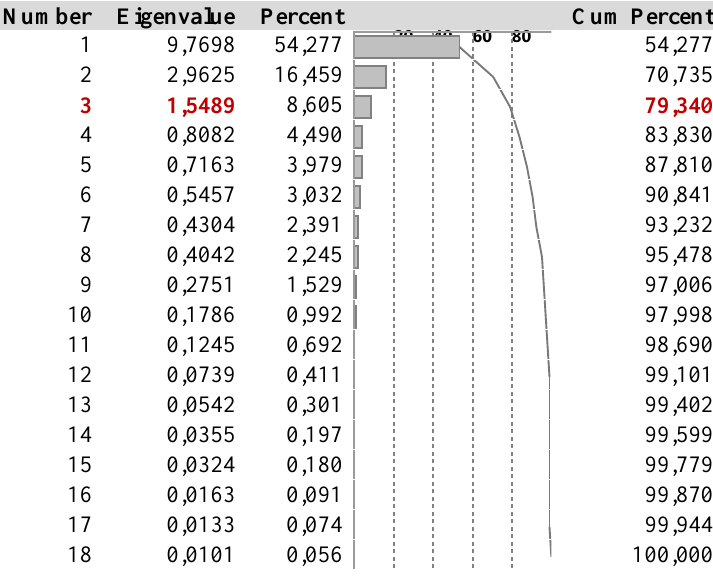
Figure 2. Eigenvalues and percent of explained